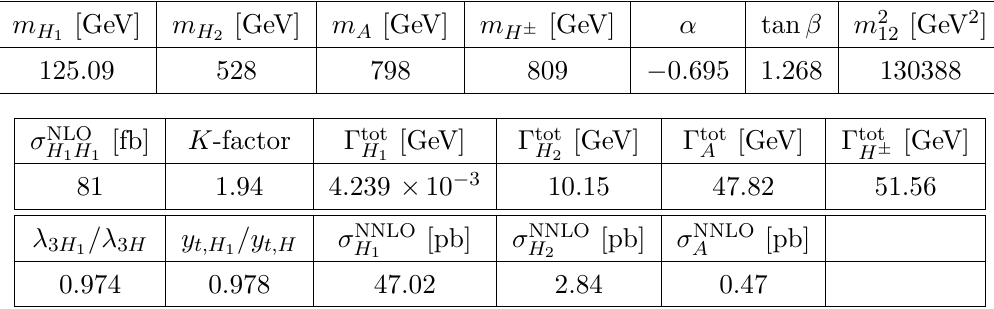
Table 9 . BP2 Upper: R2HDM-II input parameters. Lower: additional double and single Higgs production related